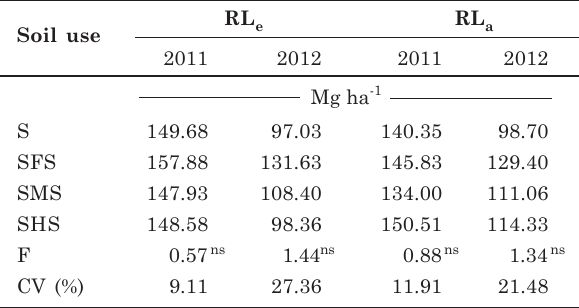
Table 6. Sugarcane productivity of the eutroferric Red Latosol (RL e ) and of the acric Red Latosol (RL a ) in 2011 and